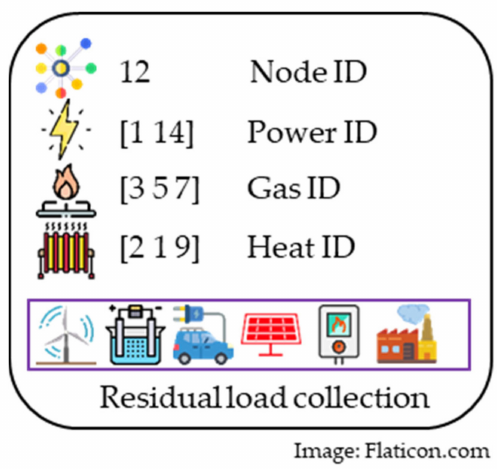
Figure 2. Example of a single node.